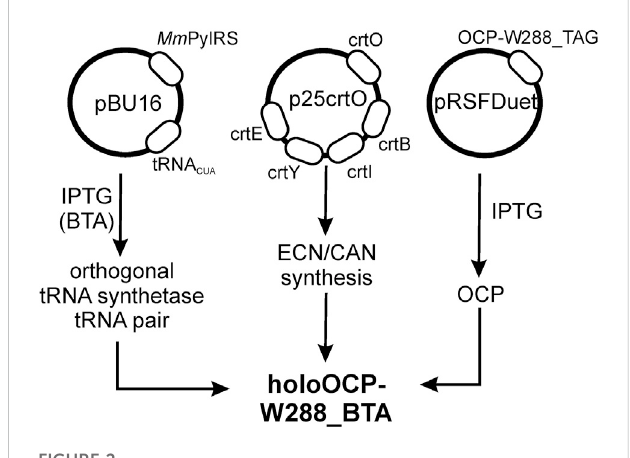
FIGURE 2 Schematic of heterologous expression of OCP-W288_BTA by stop codon suppression in E. coli . Heterologous expression was performed basedonanorthogonalpairconsistingofaspeci fi callytailored Mm PylRS and its cognate tRNA Pyl , which incorporates the non-canonical amino acid 3-benzothienyl- L -alanine (BTA) with high ef fi ciency. The Mm PylRS gene and the cognate tRNA Pyl sequence are in the pBU16 plasmid (carrying ampicillin resistance). Plasmid p25crtO harbors acontiguousgeneclusterconsistingofthegenes crtY,crtI,crtB ,and crtE from Pantoea ananatis (formerly Erwinia uredovora ) and the crtO gene from Synechocystis sp. PCC 6803 for echinenone/canthaxanthin synthesis (chloramphenicol resistance). The pRSFDuet-cTag plasmid (kanamycin resistance) carried the cDNA of the OCP construct. These plasmids were co-transformed into E. coli strain BL21 (DE3).